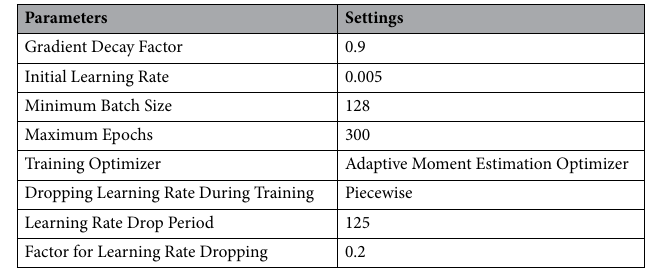
Table 2. Model hyper parameters for UNI-LSTM and BiLSTM 60 .